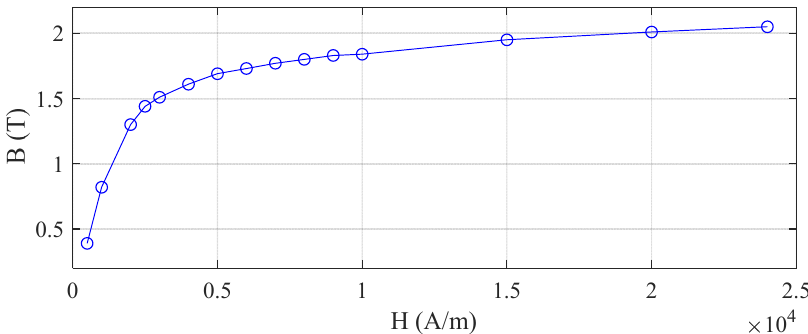
Figure 3. Nonlinear B–H ‐ characteristics of cold rolled X45 steel.